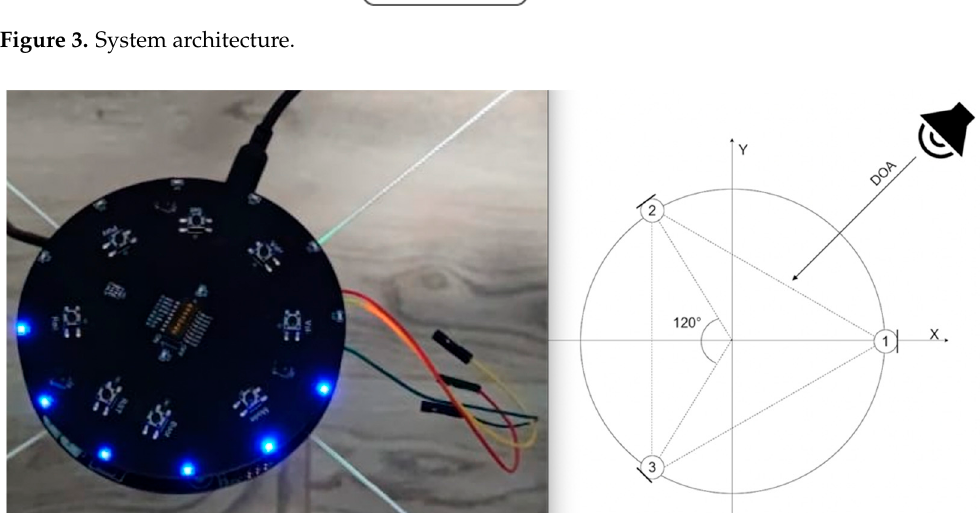
Figure 3. System architecture.